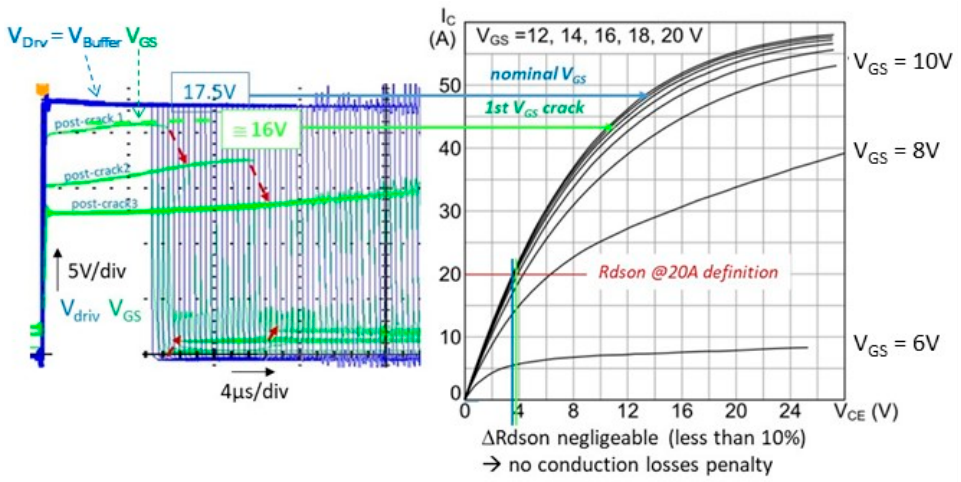
Figure 11. Gate-crack impact on R DS-ON increase using V DS depolarization.